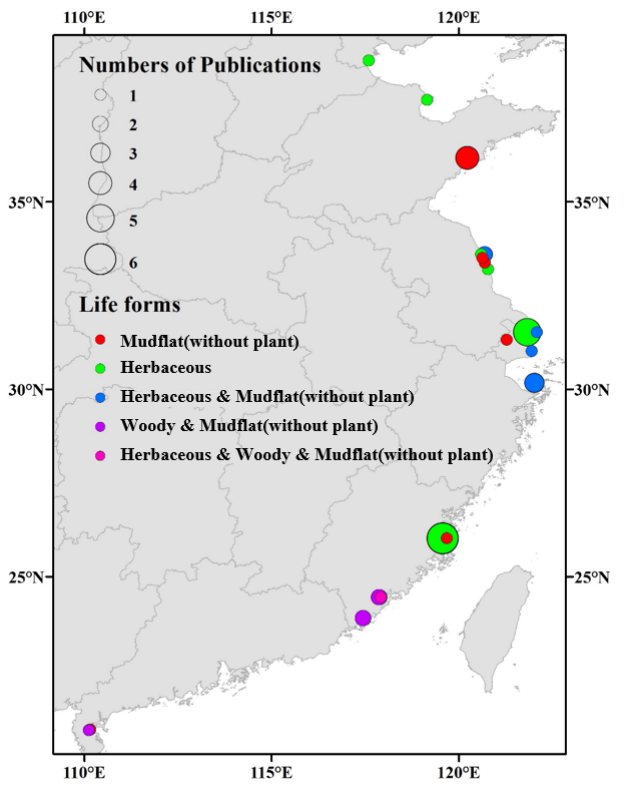
Figure 1. A distribution map of S. alterniflora invasion sites with soil sulfur data. The different colors of circles indicate various life forms of native species, and the sizes of circles represent the number of studies.